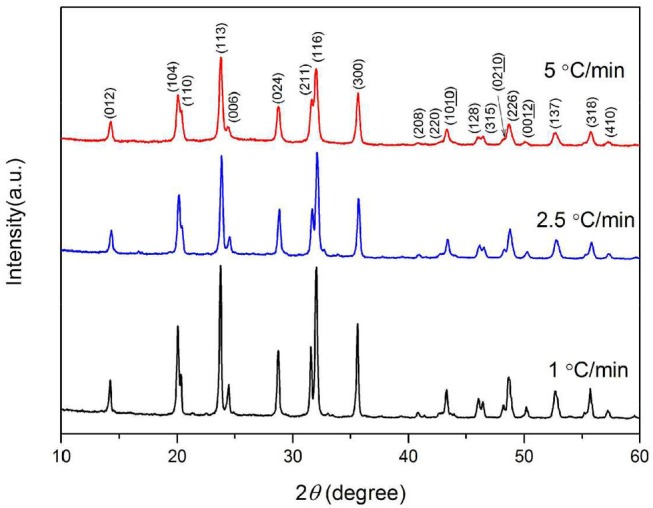
XRD patterns of Na3V2(PO4)3/C synthesized at different heating rates.